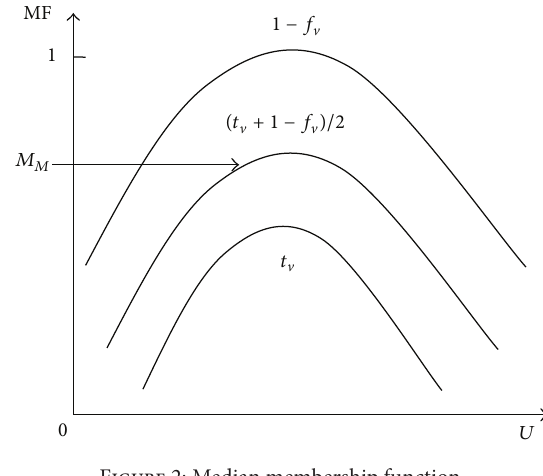
Figure 2: Median membership function.